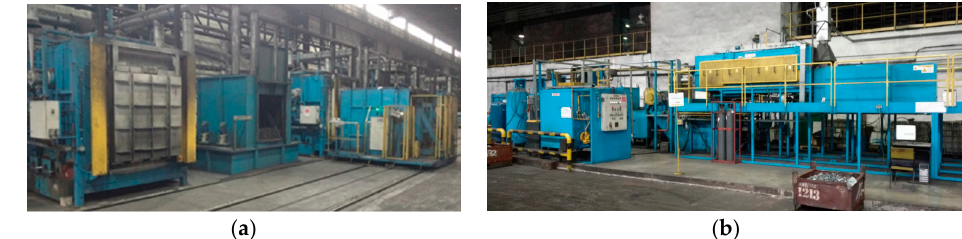
Figure 2. Exemplary images of ( a ) the stand for the thermal treatment of forgings in a chamber furnace and ( b ) the stand for the thermal treatment based on a belt furnace.